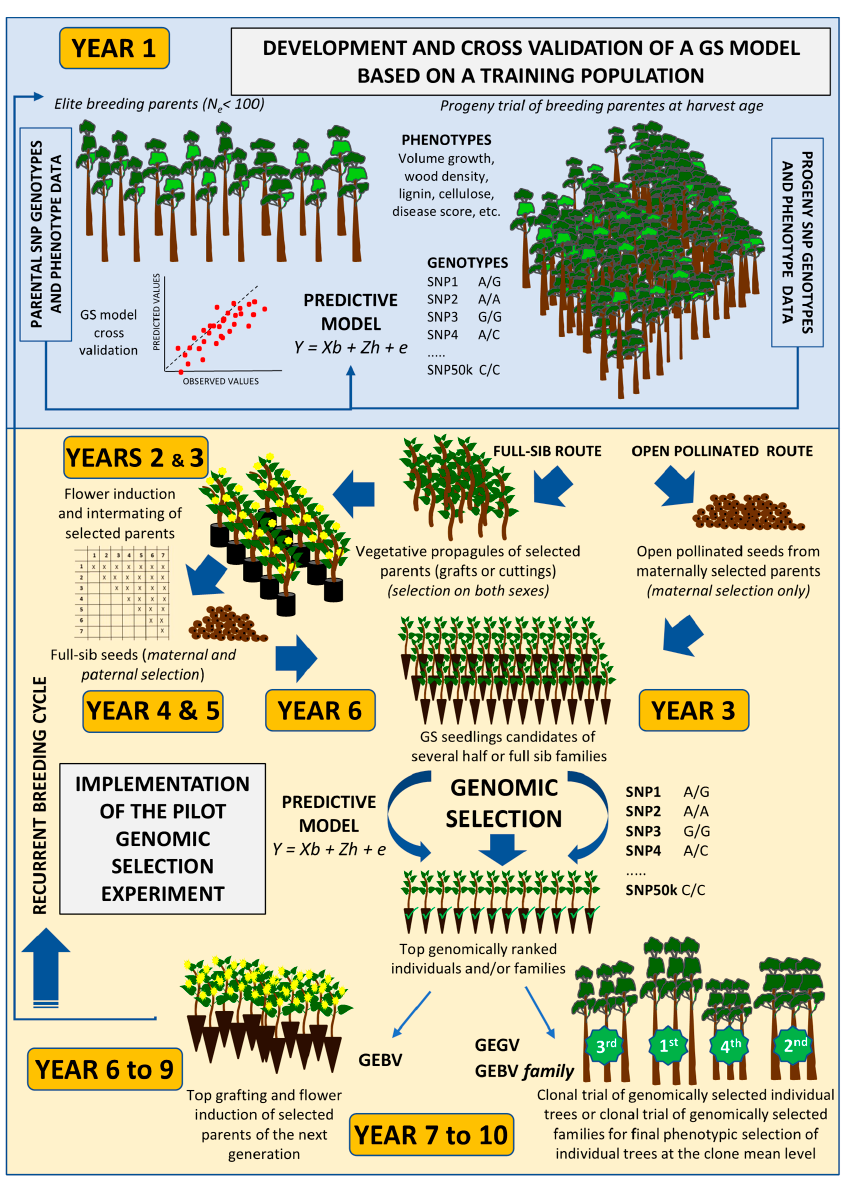
Figure 2. Step by step plan of a simple pilot project to evaluate and demonstrate the perspective of genomic selection in a recurrent selection breeding program. Timeline is suggested for a tropical Eucalyptus species, but should be adaptable to any other species (see text for details).